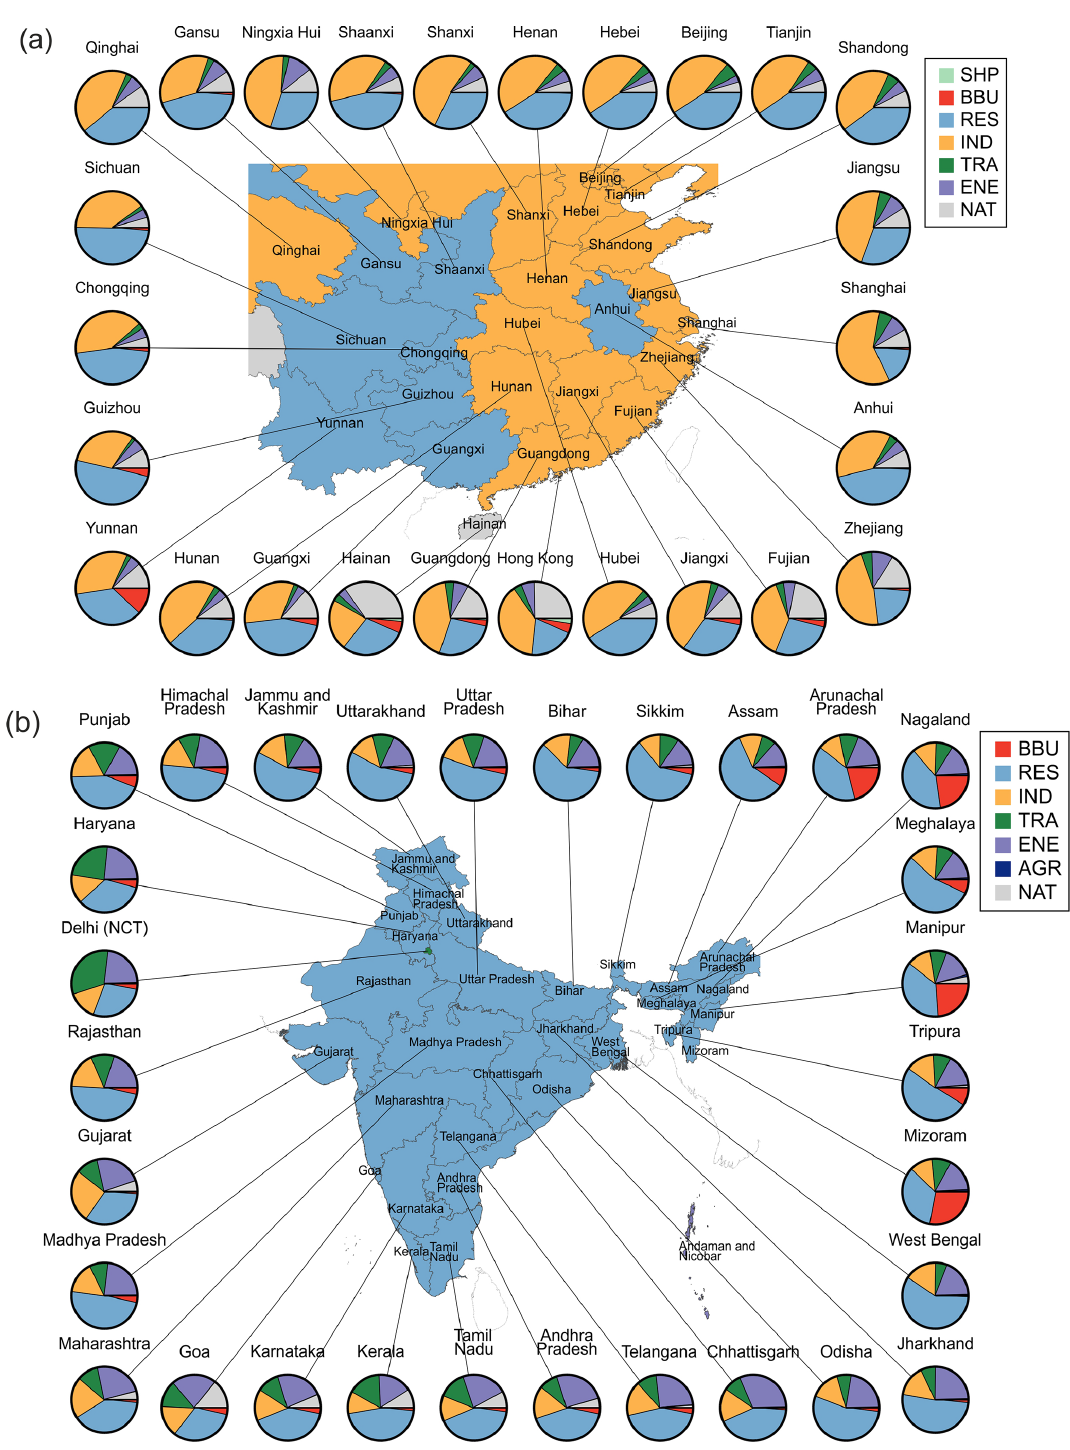
Figure 3. Contribution of different emission sectors to population-weighted annual mean PM 2 . 5 concentration (a) by province/municipality/region in China and (b) by state in India (Union Territories are not shown individually, apart from Delhi Na- tional Capital Territory (NCT)). The colour of each province in China and each state in India indicates the sector that dominates contributions to population-weighted annual mean PM 2 . 5 in that province or state. The emission sectors are agriculture (AGR; India only), power generation (ENE), industrial non-power (IND), residential energy use (RES), land transport (TRA), open biomass burning (BBU), and shipping (SHP; China only). Where the percentage contributions from each sector do not add up to 100%, the residual fraction is assigned to “Natural and other sources”